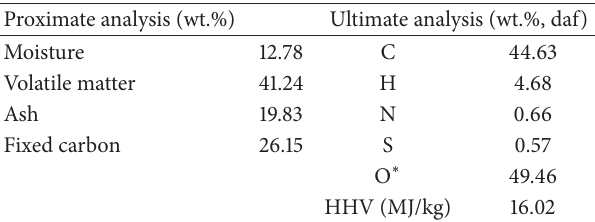
Table 1: Characteristics of the coal